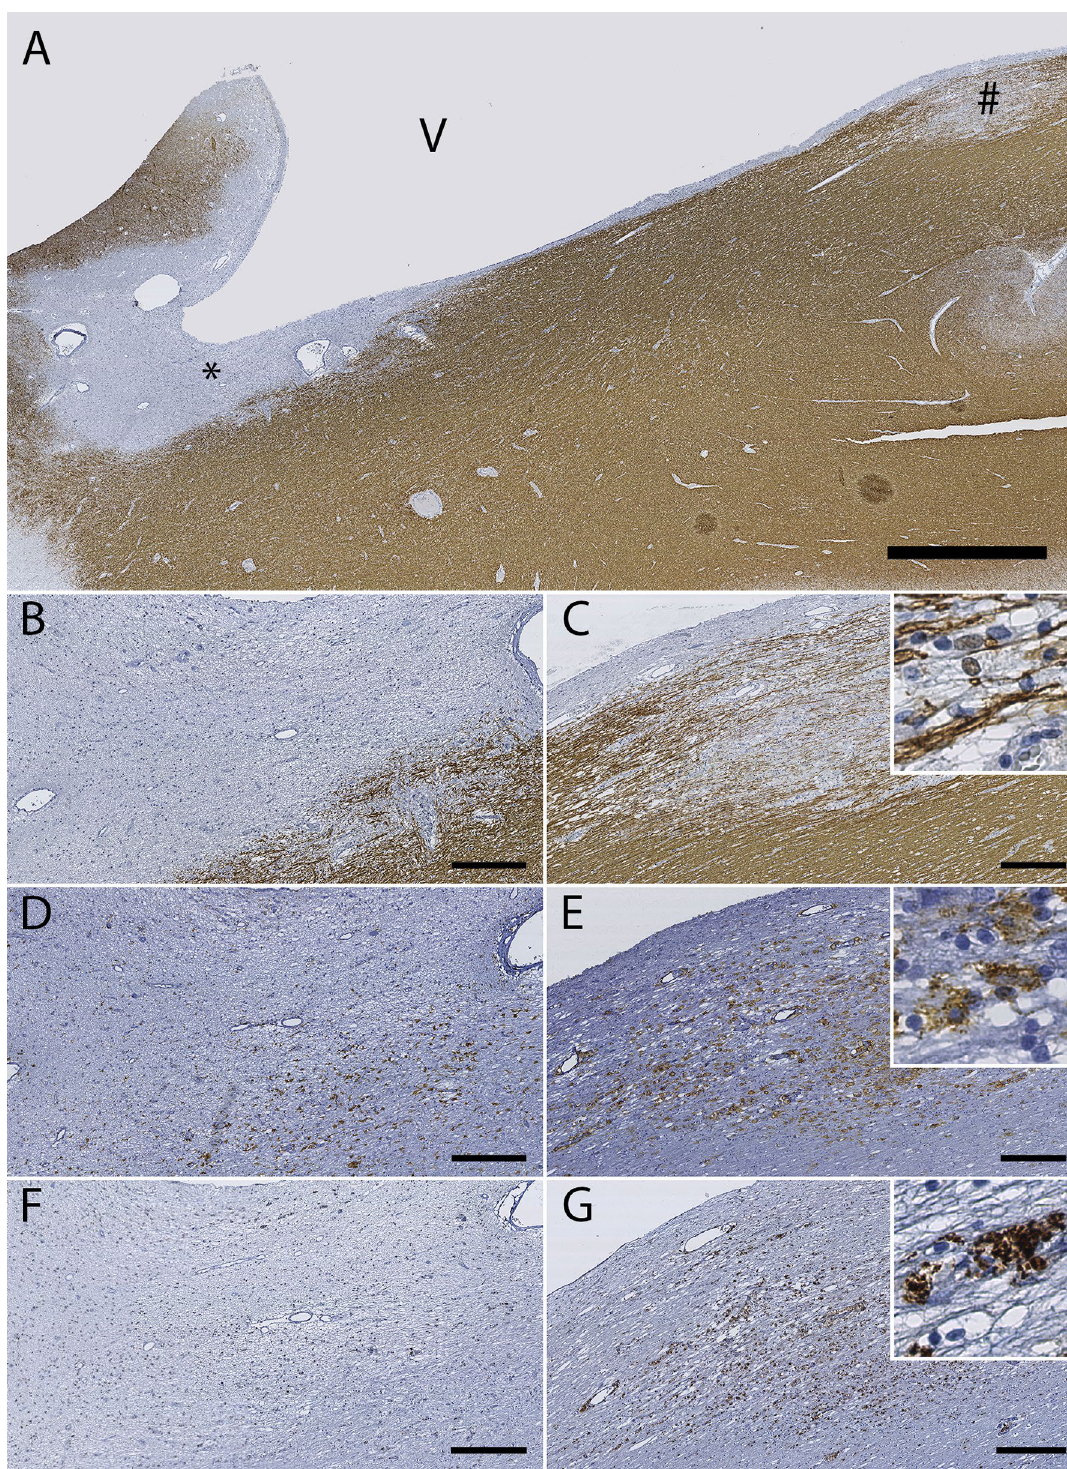
Figure 3. Expression of LGMN in white matter lesions. ( A ) Myelin (PLP) immunostained section with an active lesion (# in A , images C,E,G ) and an inactive lesion (* in A , images B,D,F ). Scale bar 2 mm. ( B,C) Myelin (PLP) immunostaining of lesions indicated in (A) at higher magnification. Scale bar 300 μm. Insert in (C) shows intracellular PLP-positive myelin debris, suggesting an early active lesion with ongoing demyelination. ( D,E ) HLA-DR immunostaining of lesions indicated in (A) . Scale bar 300 µm. Insert in (E) shows activated HLA-DR positive cells. ( F,G ) LGMN immunostaining of the lesions indicated in (A) . Scale bar 300 µm. In (G) , increased LGMN expression is seen throughout the active lesion, while in the chronic inactive lesion (F) , there is reduced LGMN expression, due to general hypocellularity and absence of HLA-DR positive cells. Insert in (G) shows a representative image of LGMN immunostaining in a pattern compatible with cytoplasmic